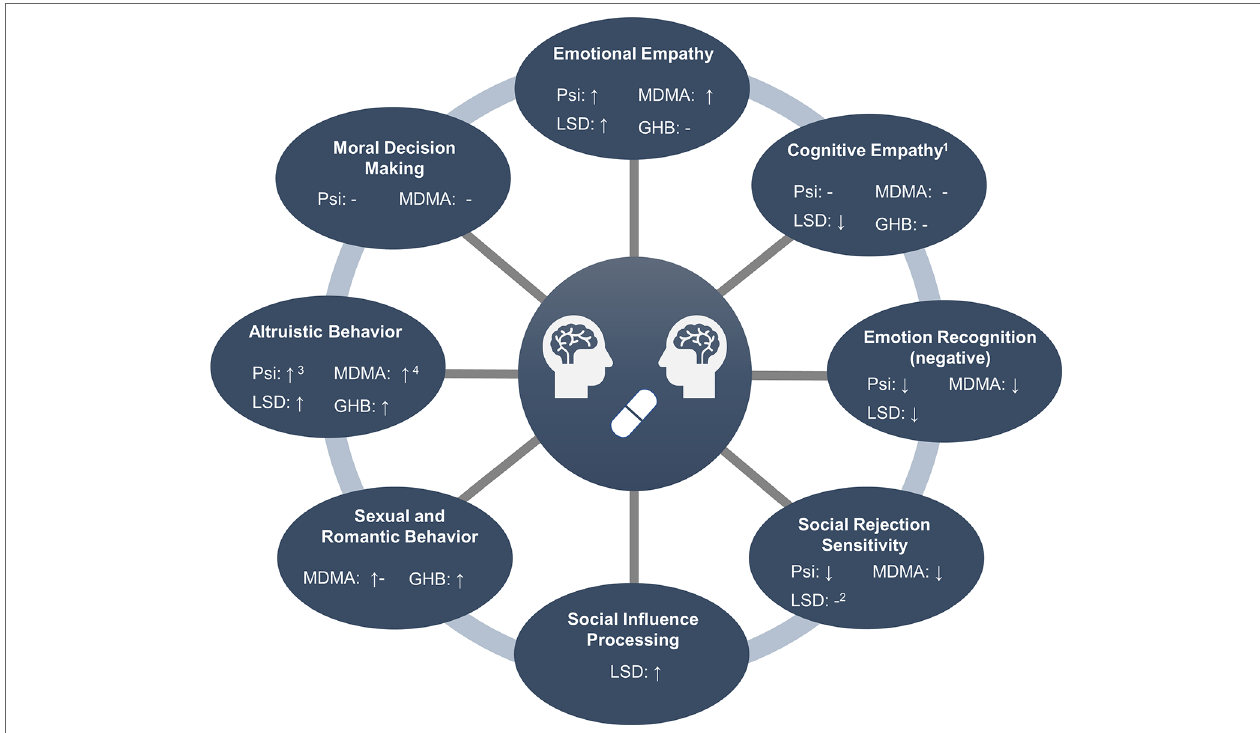
FIGURE 1 | Overview of social processes modulated by entactogens and hallucinogens. 1 Measured with the Multifaceted Empathy Test. 2 Only assessed after the administration of low doses (≤26 µg). 3 Assessed in male participants only. 4 In men and when directed toward friends, but not strangers.